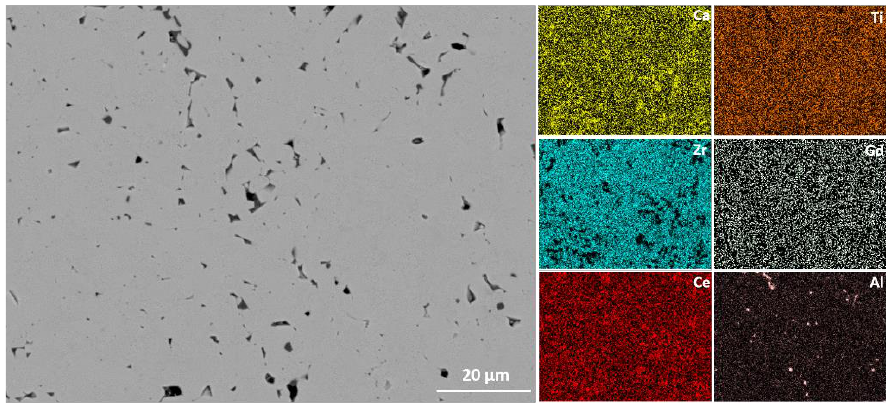
Figure 3. SEM micrographs of HIPed Sample C.1 at 400 rpm during 120 min.